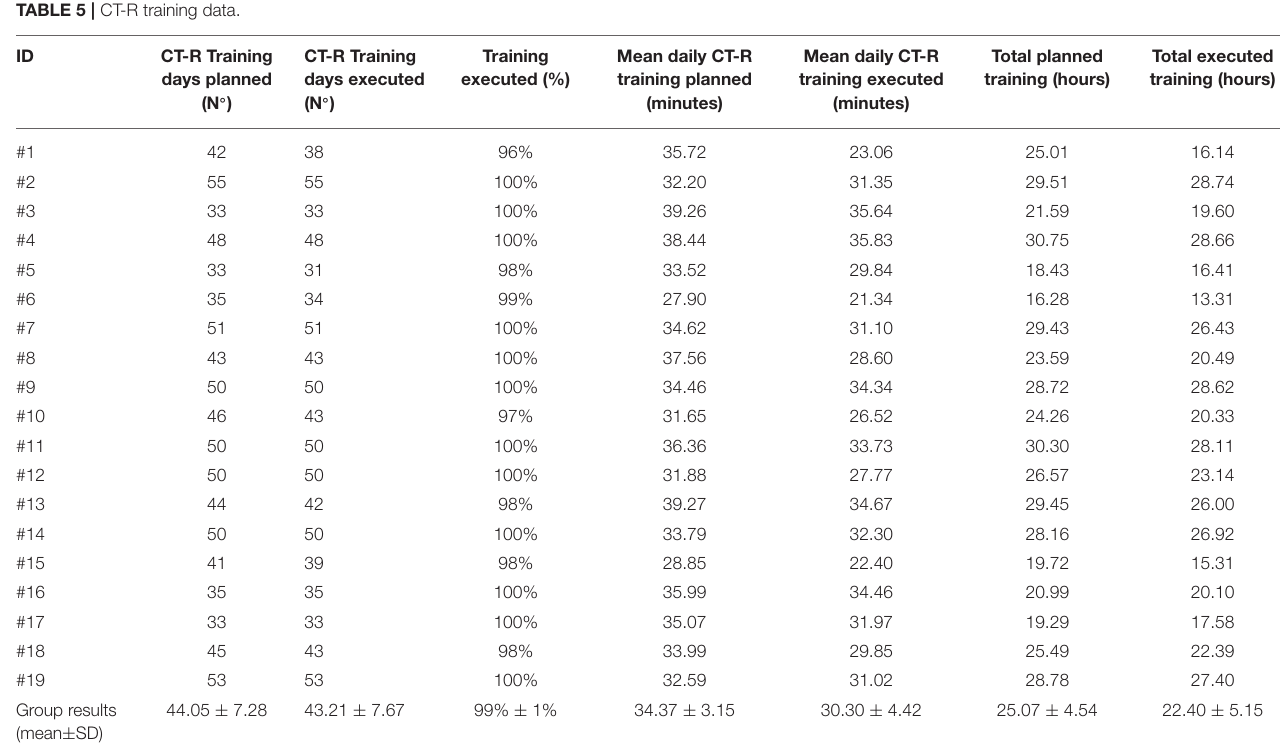
TABLE 5 | CT-R training